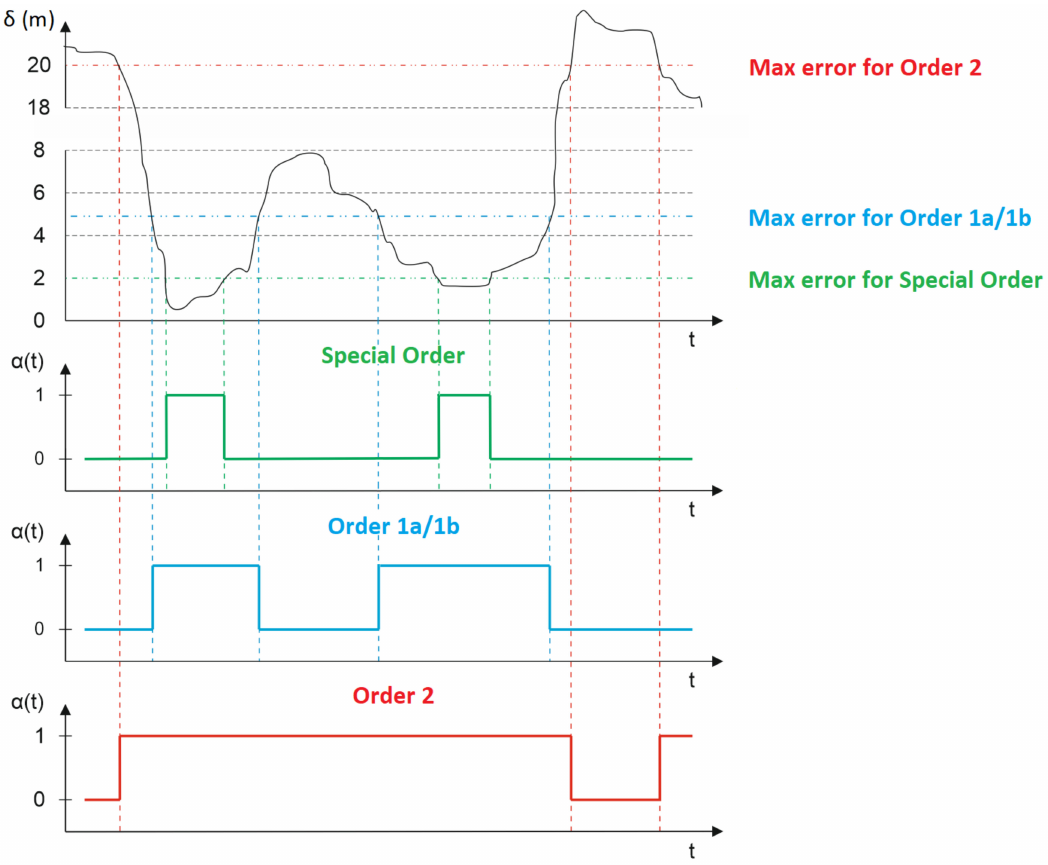
Figure 2. The position error as a function of time (the upper diagram) and three diagrams corresponding to the operational status for the IHO orders: special (green colour), 1a / 1b (blue colour), and 2 (red